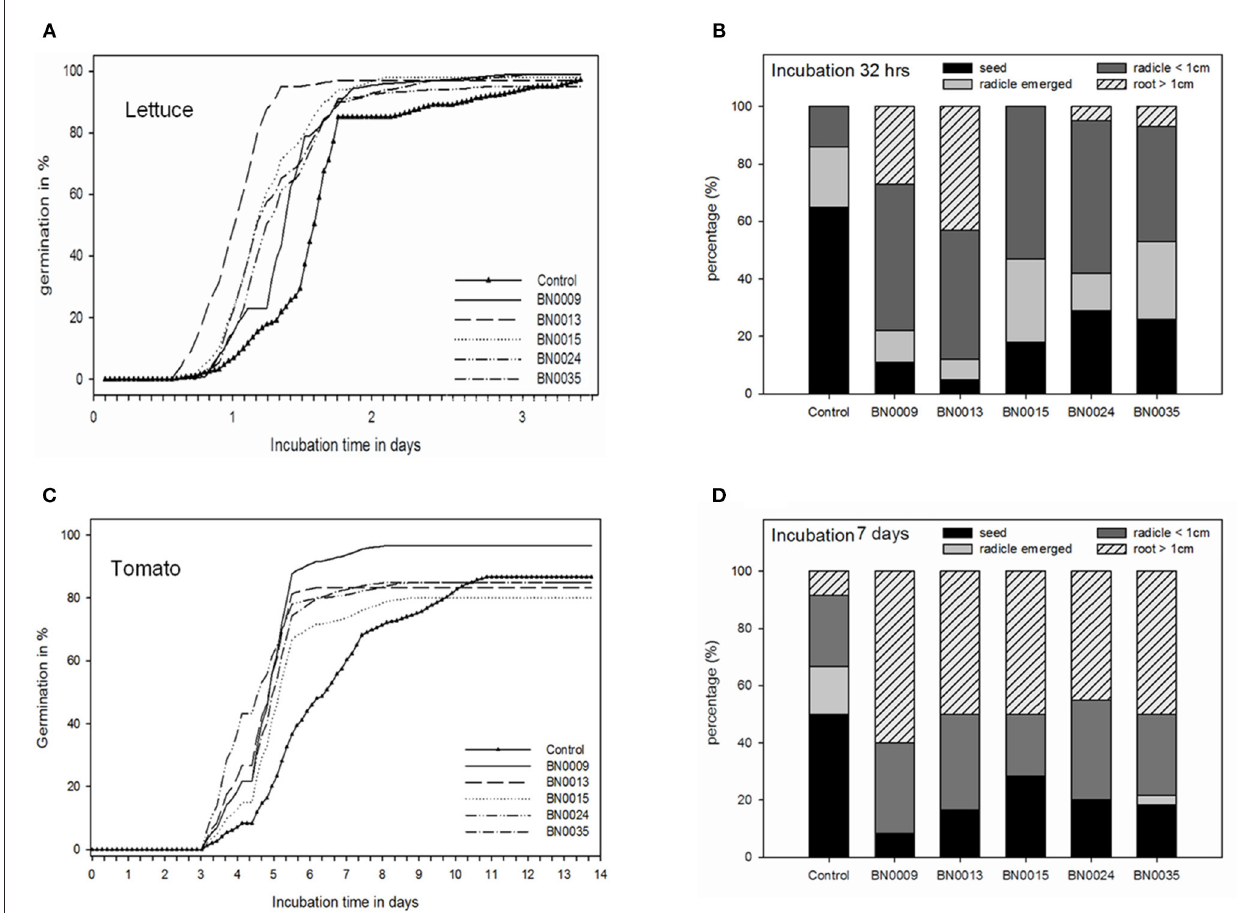
FIGURE 4 | Characterization of the bacterial effect on germination and early root growth in lettuce and tomato; (A) germination over time in lettuce; (B) comparison of bacterial treatments regarding root growth categories in lettuce seedlings at 32h of incubation; (C) germination over time in tomato; (D) comparison of bacterial treatments regarding root growth categories in tomato seedlings at 7 days of